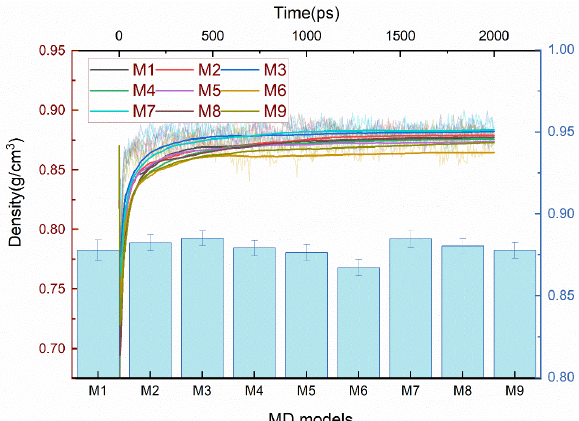
Figure 9. The density of varied cross-linked EPDM MD models. The fluctuation curves are the den- sity evolution of 2000 ps NPT, the smoothed curves are the average density of the kinetic process, and the histogram is the average of the three independent MD models.